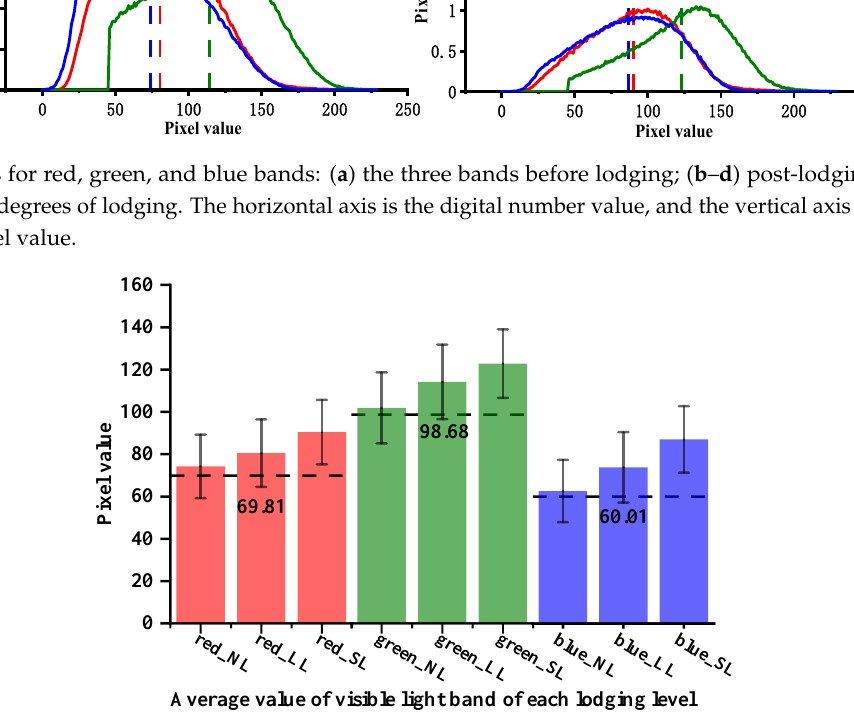
plot with different degrees of lodging. The abscissa gives the vegetation index, and the ordinate gives the number of pixels. The gray histograms of the vegetation indexes for different degrees of lodging show the distribution of the single peak. With increasing degree of lodging, the peak of the histograms of the GRRI, GRVI, MGRVI, SAVI, EXGR, and VARI all shift to the lower values, whereas the peak value of the WI shifts to higher values. Combining these results with the change in the average pixel value for each degree of lodging (Figure 12) shows that the CIVE and GRRI remain relatively unchanged as the degree of lodging increases. As with the change ∆DSM0804 from the digital surface model, the trends of GRVI, MGRVI, SAVI, EXGR, and VARI correlate negatively with degree of